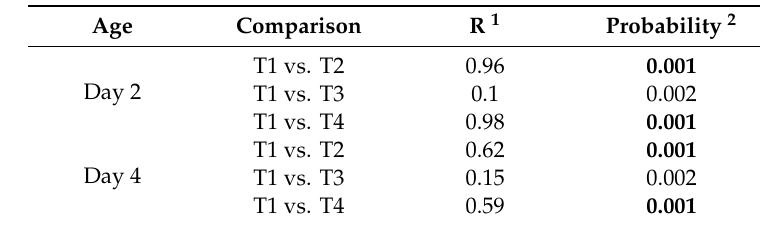
Table 3. ANOSIM analysis of weighted Unifrac on di ff erent day comparisons within each of the treatment